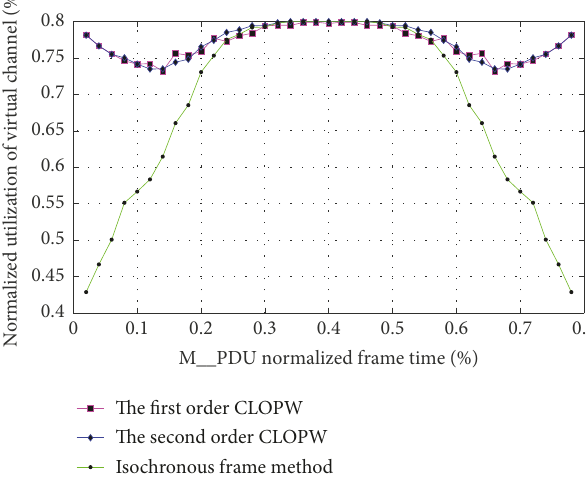
Figure 5: Comparison of normalized utilization of virtual channel.